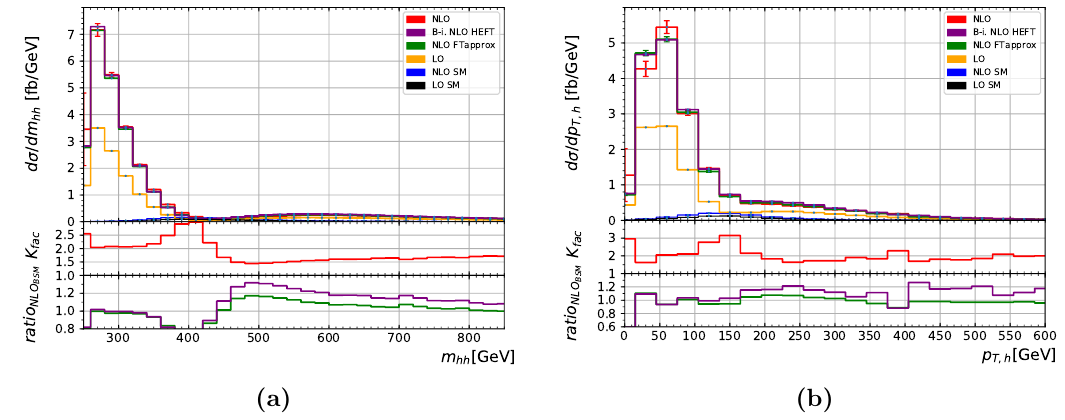
Figure 22. Same as (cid:12)gure 12 but for benchmark point 10, c hhh = 10 ; c t = 1 : 5 ; c tt = (cid:0) 1 ; c ggh = c gghh = 0.